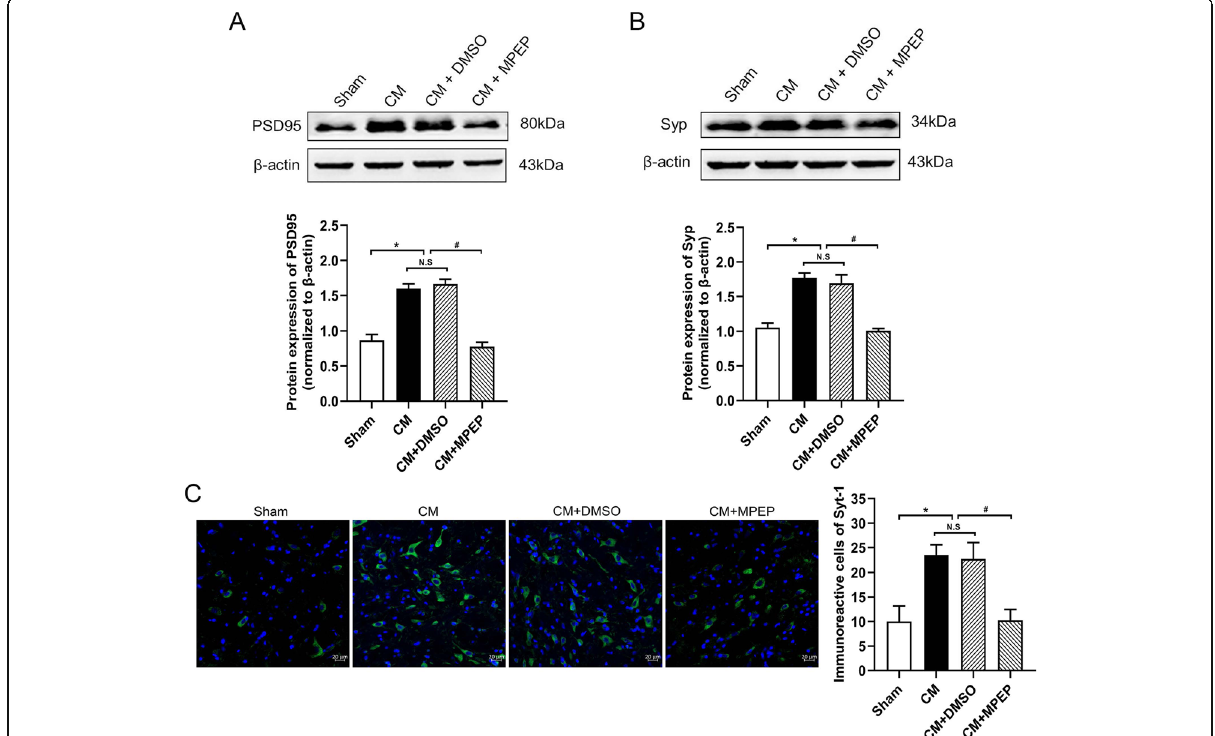
Fig. 4 The effect of MPEP on synaptic associated proteins. Compared with the sham group, the expression of PSD95, Syp, and Syt-1 upregulated in the CM group. There were no significant differences between the CM and CM + DMSO groups. The administration of MPEP significantly decreased their expression. a The protein expression of PSD95. b The protein expression of Syp. c Immunoreactivity for Syt-1. ( n = 4 in each group,scale bar = 20 μ m; *p < 0.05 compared with the sham group; # p < 0.05 compared with the CM + DMSO group; N. S:p > 0.05